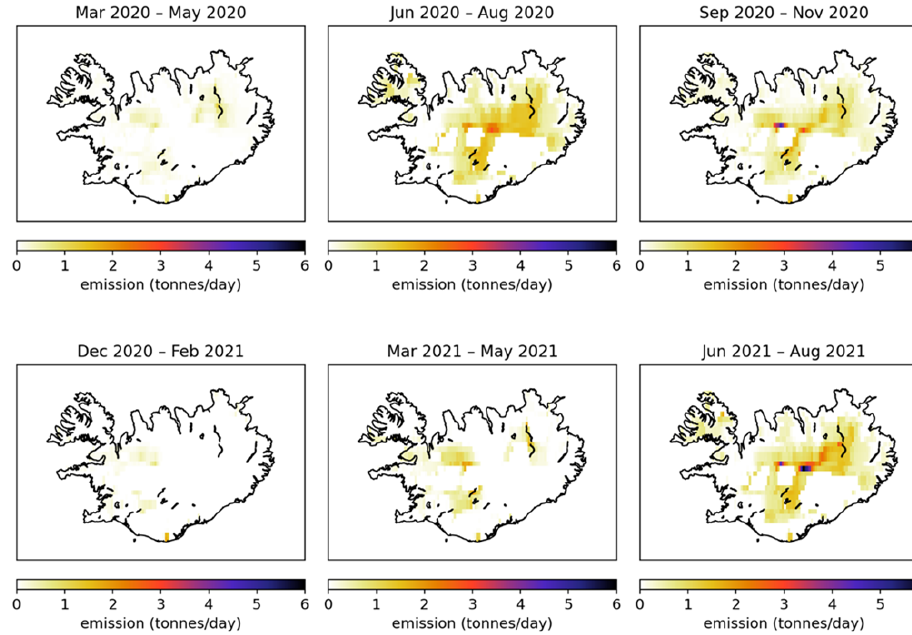
Figure 12. SILAM-modeled dust emissions (tonnes per day) in Iceland for 3-month periods in March 2020–August 2021. Table 4. Major ions (mgL − 1 ), pH value, dust content (mgm − 2 in snow), and deposition rate (mgm − 2 d − 1 ) during winter at HLD source nos. 7 and 8 in Fig.